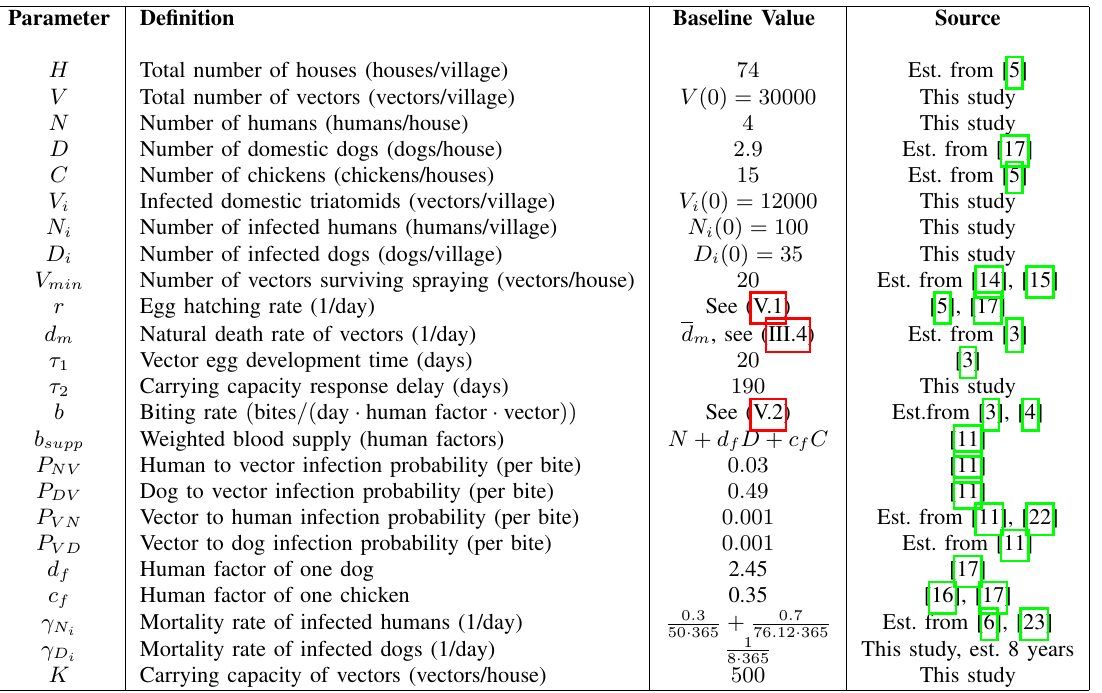
T HE MODEL PARAMETERS AND THE BASELINE SIMULATION